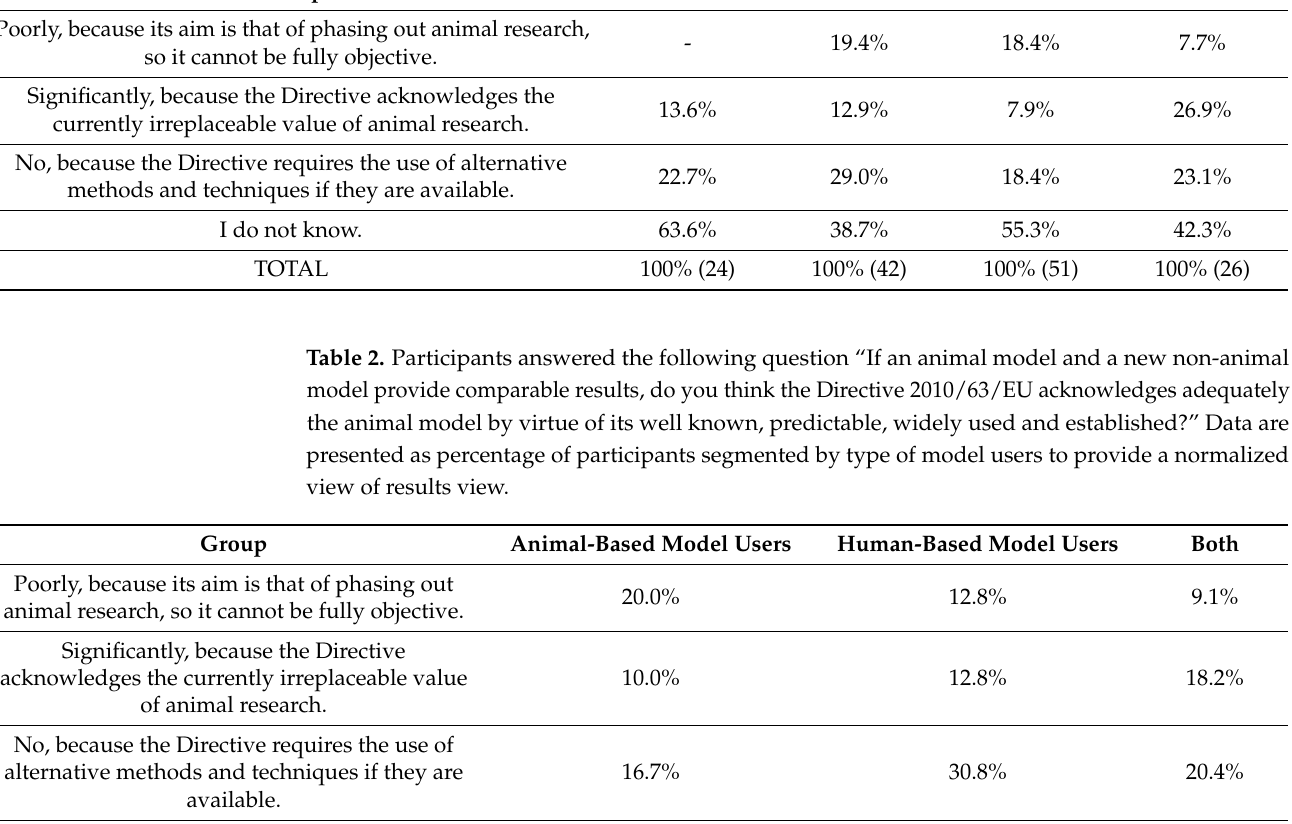
Table 1. Participants answered the following question “If an animal model and a new non-animal